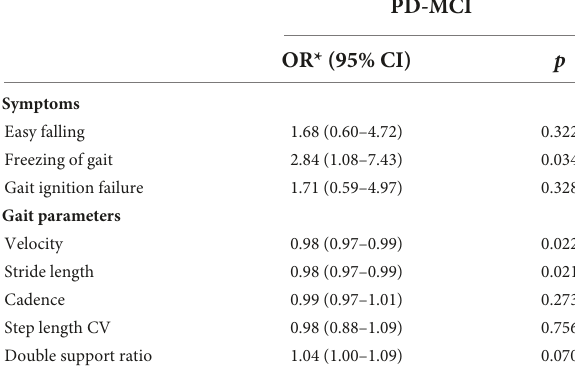
TABLE 3 Odds ratio for PD-MCI in patients with PD.